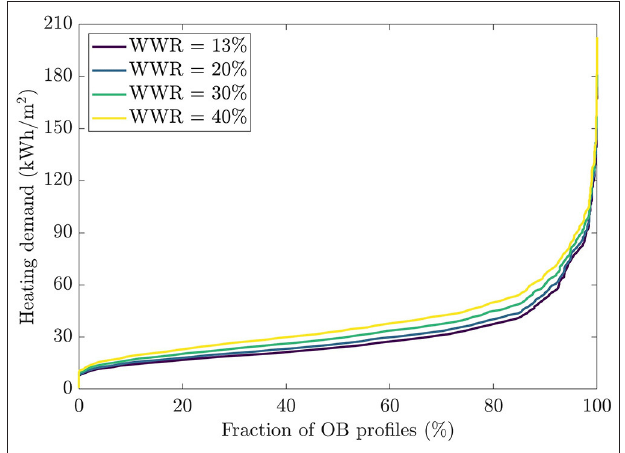
FIGURE 4 | Probability distribution of number of hours of discomfort depending on occupant behavior and window-to-wall ratio. TABLE 1 | Statistical summary of the distribution of the annual number of hours of discomfort for 1,000 occupant profiles when changing the window-to-wall ratio.